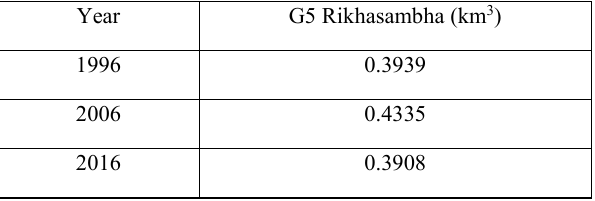
Table 4. Volume of Glaciers at Different Years